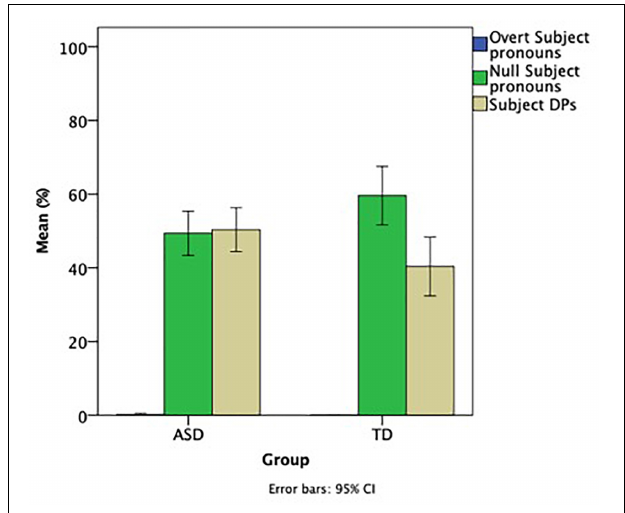
FIGURE 1 | Ratio of null, overt subject pronouns and subject